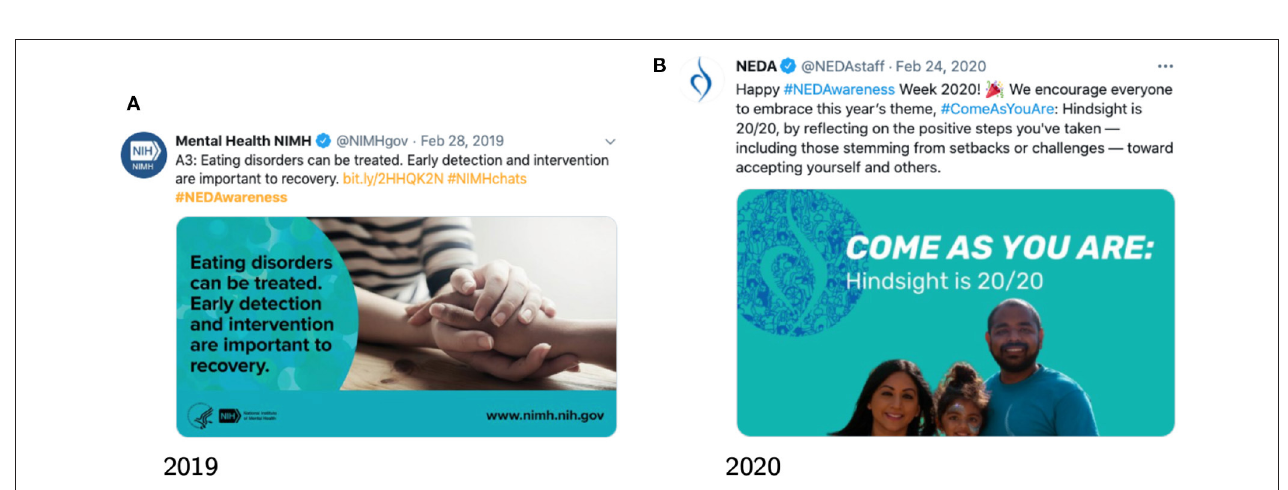
FIGURE 2 | Example posts during the NEDAwareness